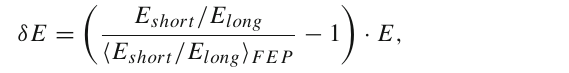
events from the 2615 keV line in calibration data. The clas-